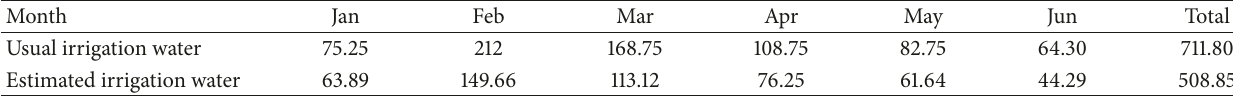
Table 3: Usual and estimated irrigation water from January to June